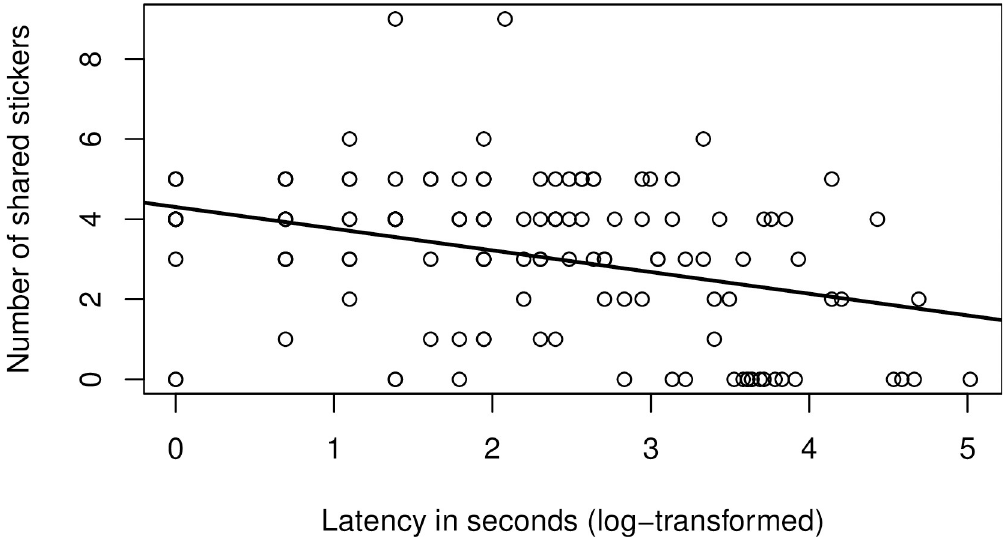
Fig 3. Depiction of the correlation between the log-transformed latency to share stickers and the number of stickers shared.